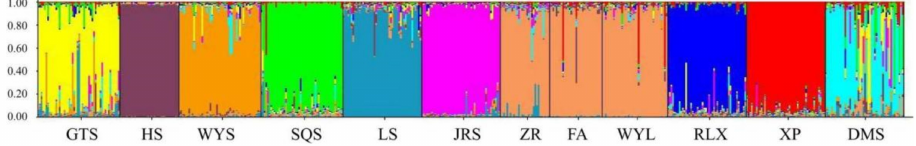
Figure 4. Population genetic structure based on the Bayesian clustering model among 528 samples of C. chekaingoleosa at K = 10. Each color represents a genetic